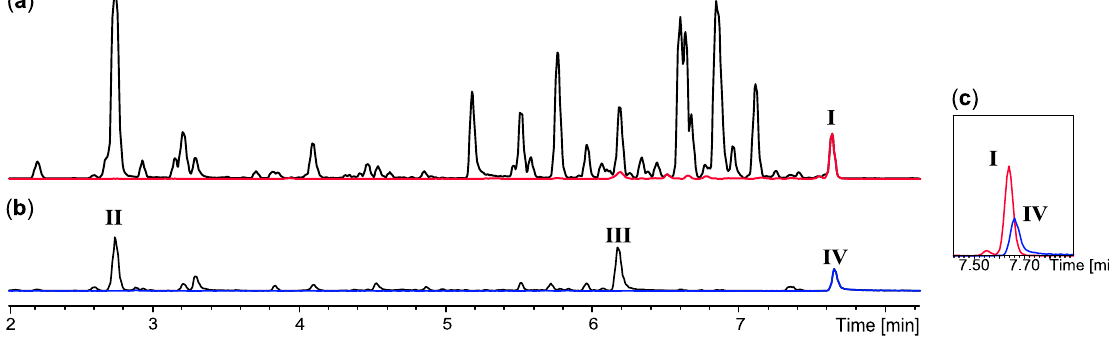
Figure 3. E-SPE strategy based on a SAX column to separate co-eluting compounds in the crude extract of P . brasilianum . ( a ) UHPLC chromatograms of the SAX fraction that contained neutral/basic compounds. The ion trace of compound I ( m/z 462.2387) is marked with red; ( b ) UHPLC chromatogram of the SAX fraction that contained acidic compounds. The ion trace of compound IV ( m/z 548.1916) is marked with blue; ( c ) In the crude extract compound I and IV were co-eluting on a RP C 18